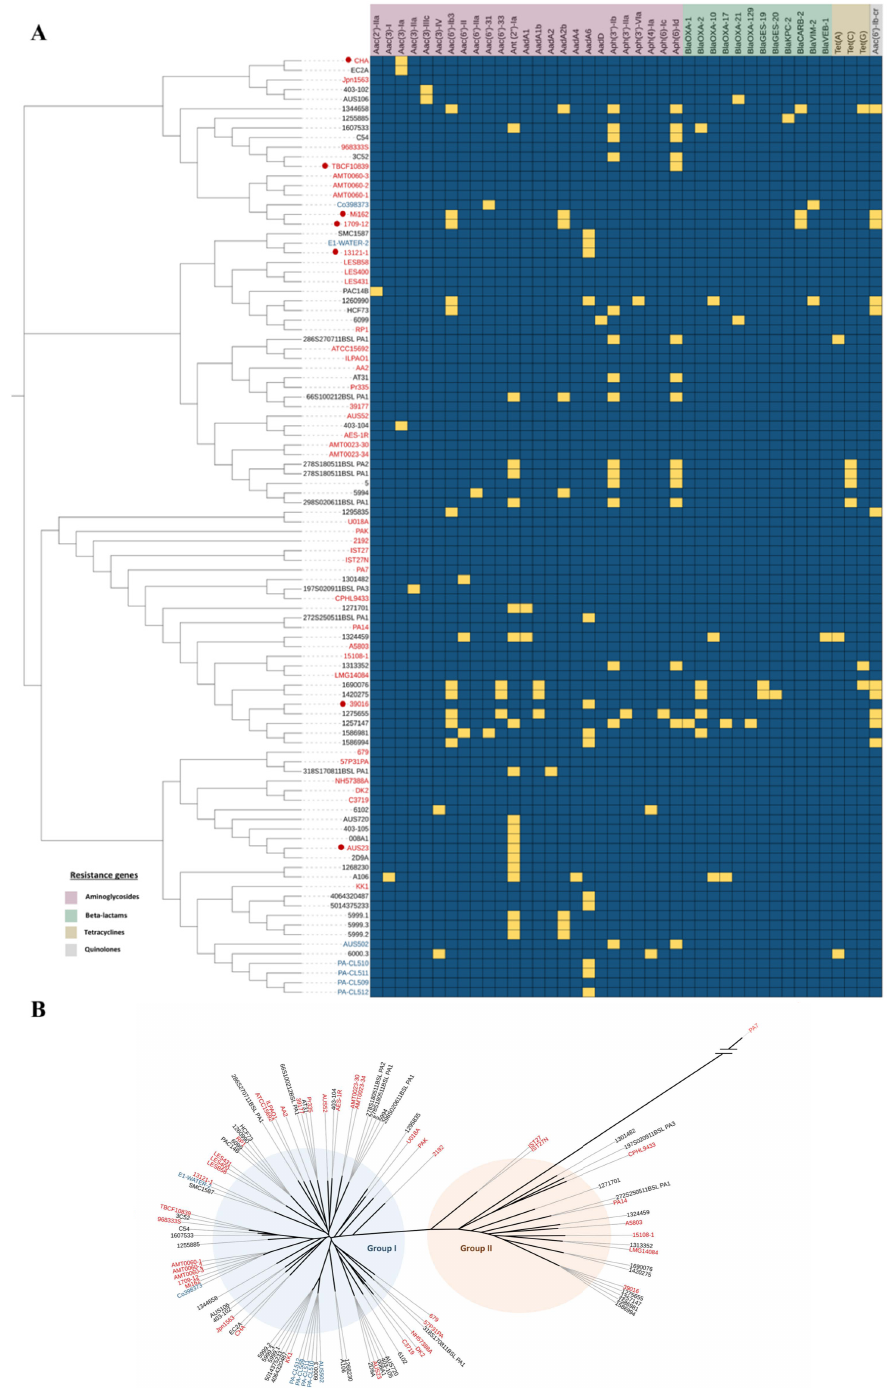
Figure 1. Phylogenetic analysis of isolates with acquired antibiotic resistance genes. ( A ) Antibiotic resistance gene profiling, with relationships between isolates displayed through a phylogenetic tree. The presence of a resistance gene is shown in yellow and absence in blue. ( B ) An unrooted phylogenetic tree of reference panel genomes and of genomes that contain acquired resistance genes. Forty-two reference panel genomes are shown in red with those containing horizontally transferred resistance genes indicated by red dots. Other genomes containing horizontally transferred resistance genes are shown in black (clinical) and blue (environmental). Trees were generated from whole genome sequences using ParSNP and visualised using iTOLv6.